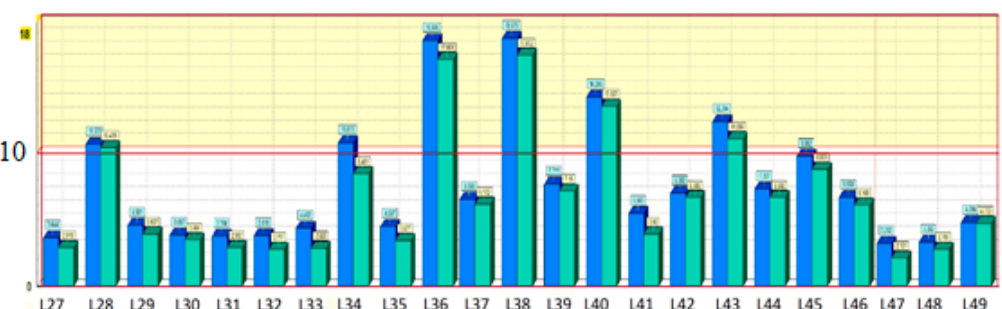
Figure 6. Changes in the tangential component gradient for the selected sub-area under analysis.